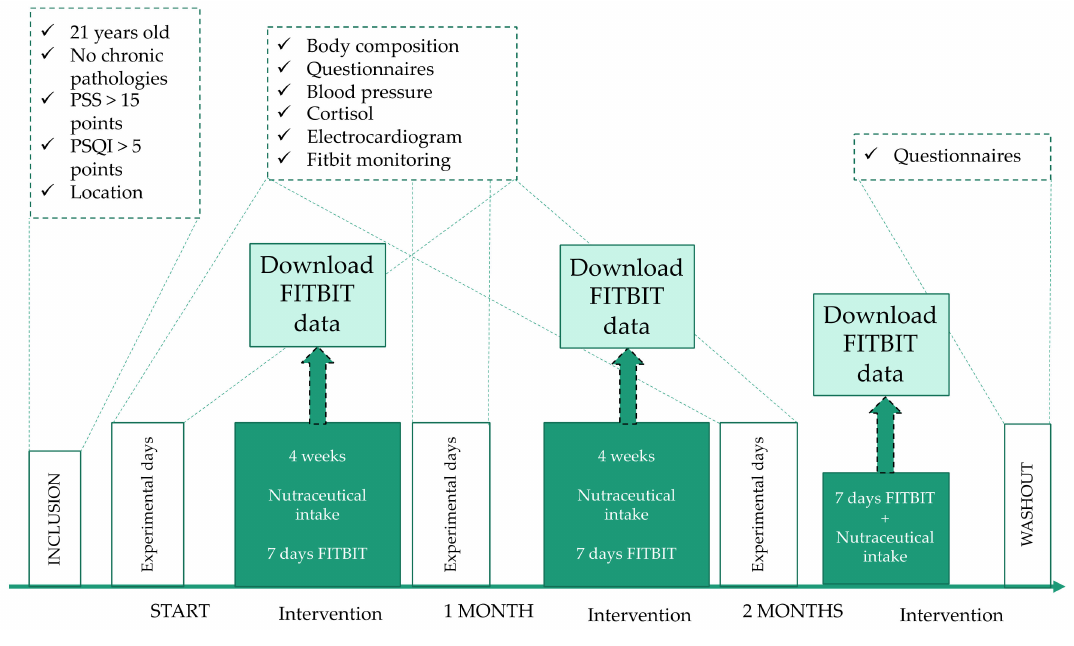
Figure 3. Design and development of the intervention. PSS = perceived stress scale; PSQI = Pittsburgh sleep quality index.